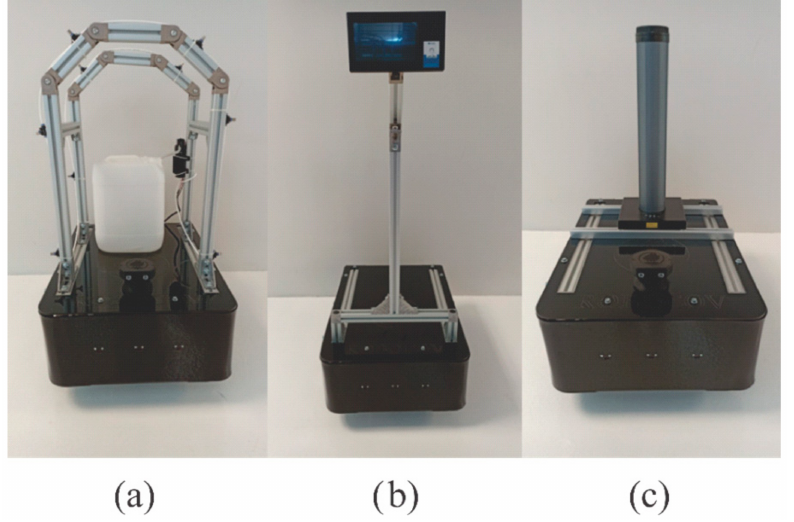
Figure 24. Prototype of Robocov modules: ( a ) sanitizing solution module; ( b ) monitoring module; ( c ) UV light